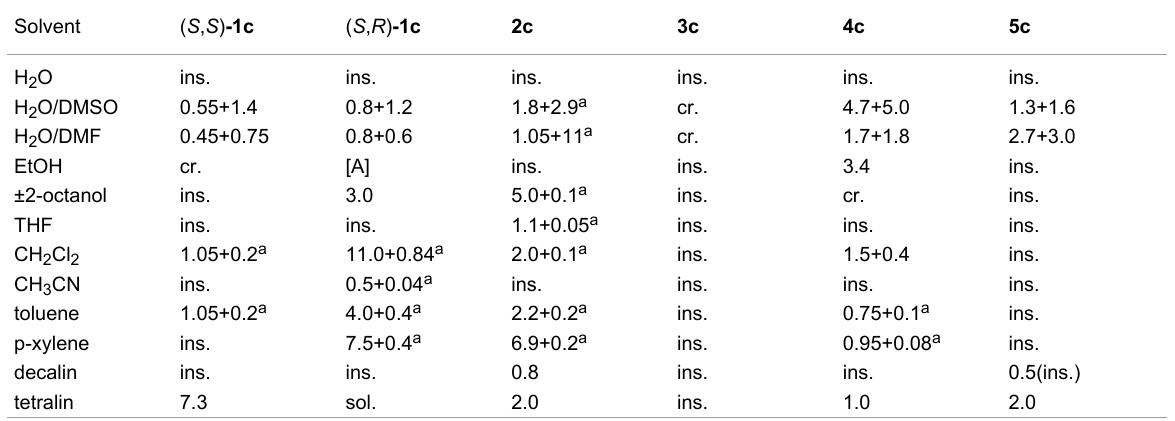
Table 3: Gelation effectiveness (G eff , mL) of bis(amino acid and dipeptide-CONH 2 )oxalamides 1c – 5c in gelation of various solvents and solvent mixtures (sol.: soluble, ins.: insoluble; cr.: crystalline; [A] gel/sol mixture). Solvent ( S , S ) -1c H 2 O ins.